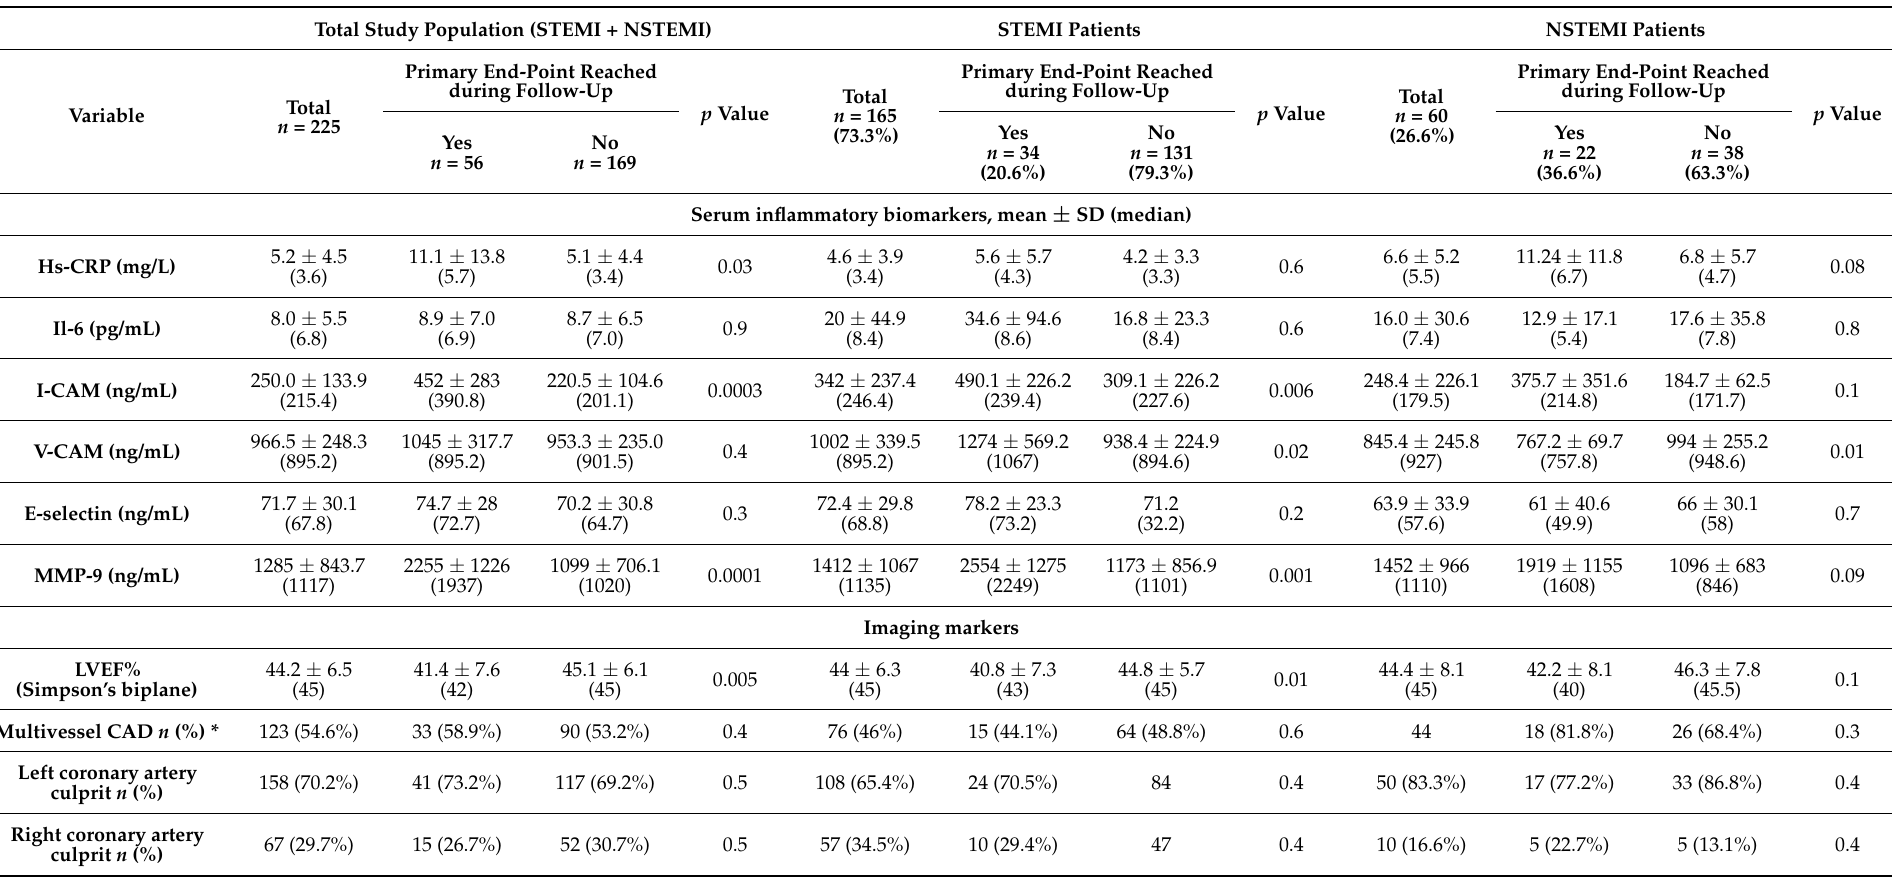
Table 3. Serum biomarkers and imaging